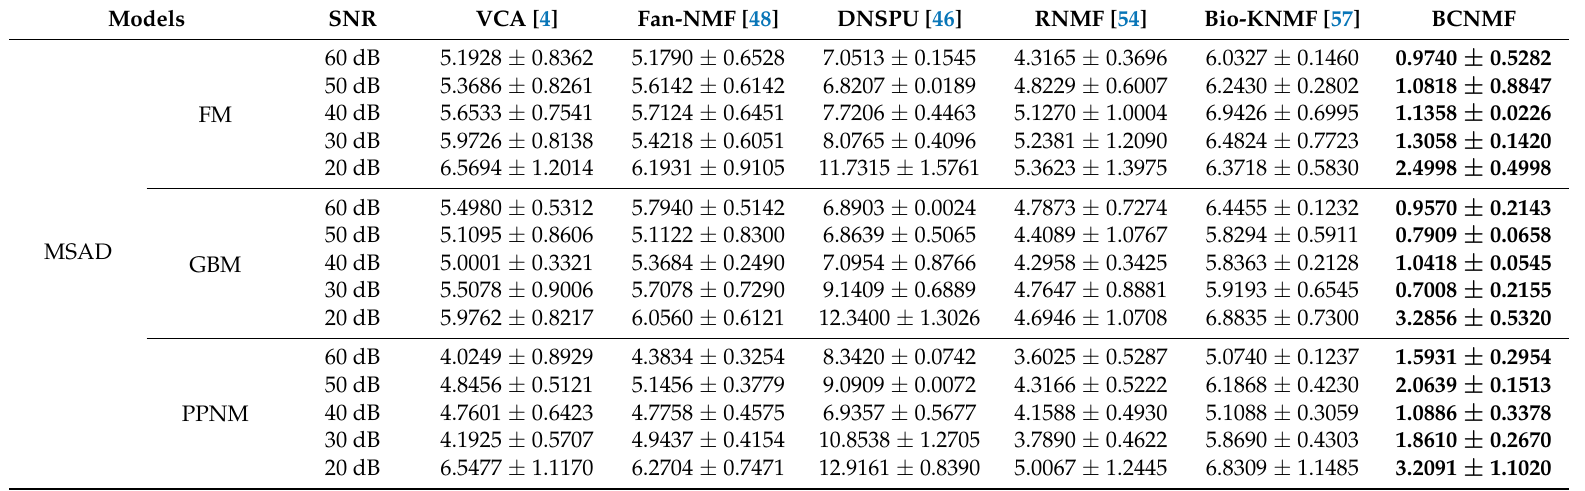
Table 6. MSADs of all algorithms with different